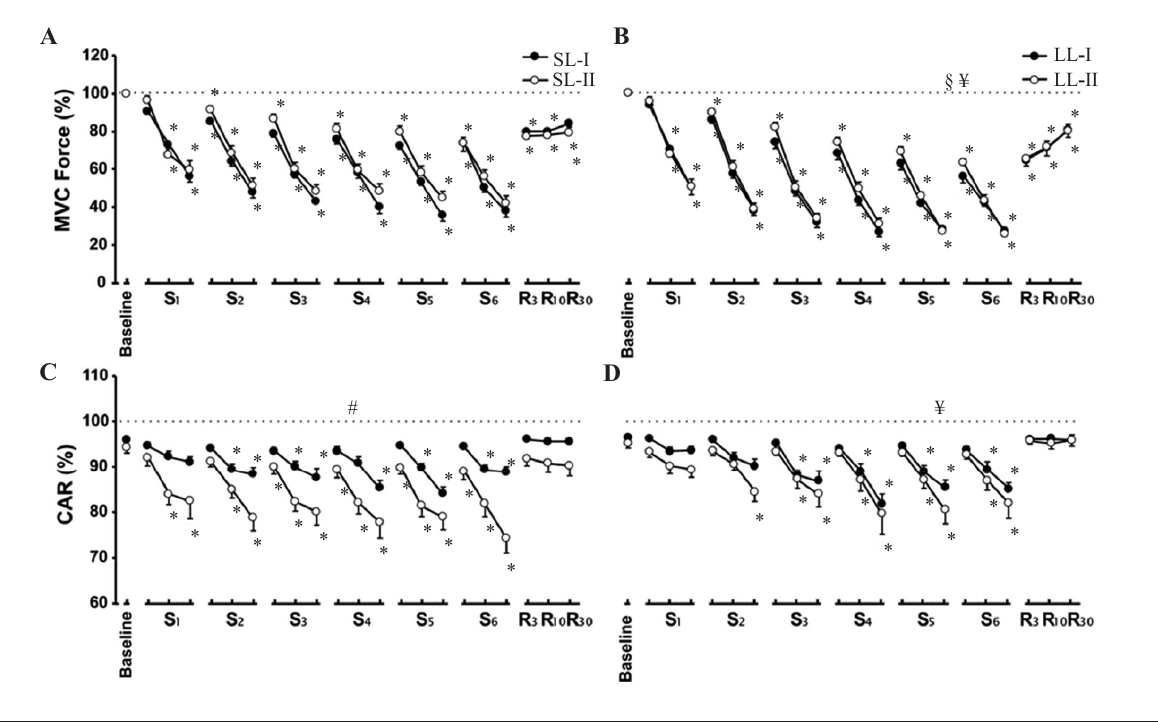
Figure 2. Maximal voluntary contraction and central activation ration results after each series of sustained maximal (uni-)bilateral